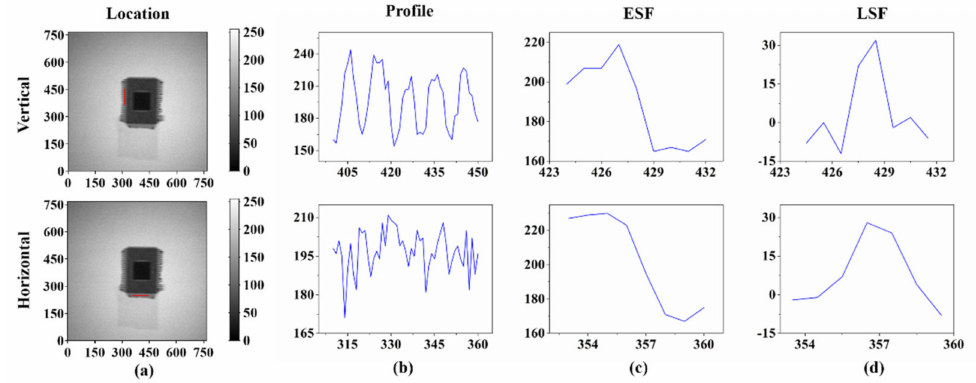
Figure 8. ( a ) Shows the two locations chosen from horizontal and vertical directions for data processing (see the red line). ( b – d ) Profile, edge spread function, and line spread function